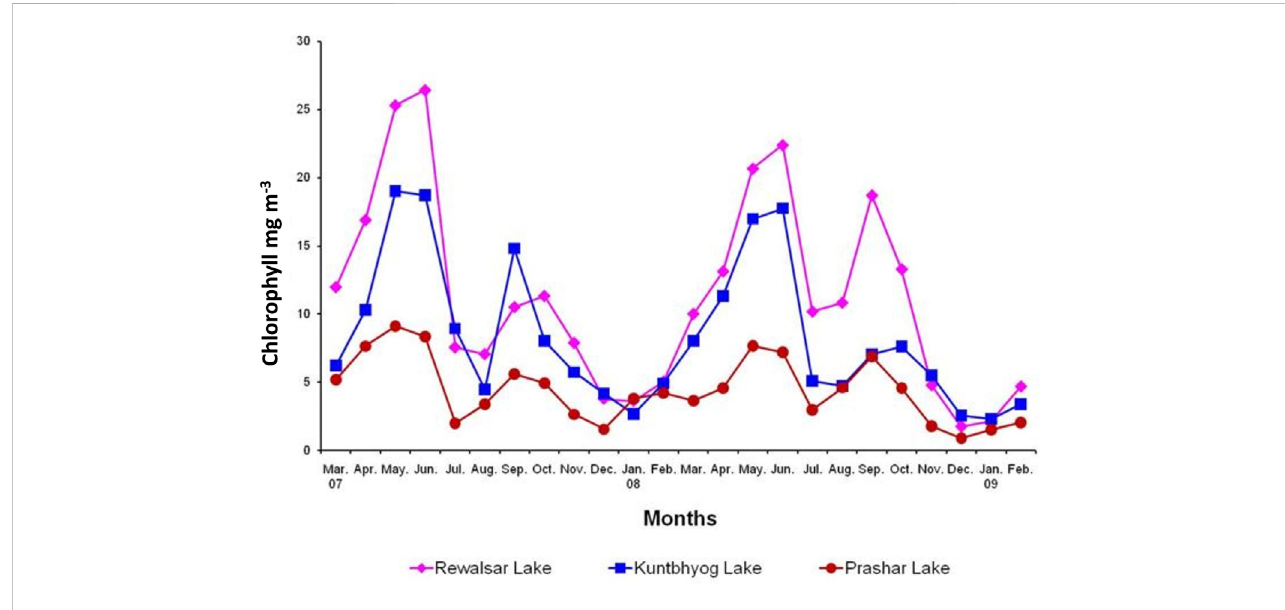
FIGURE 2 Monthly fl uctuations in chlorophyll ‘ a ’ in different lakes.